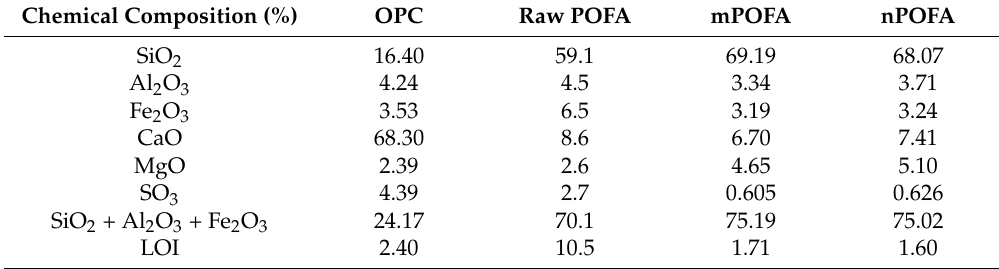
Table 4. Chemical compositions of OPC and